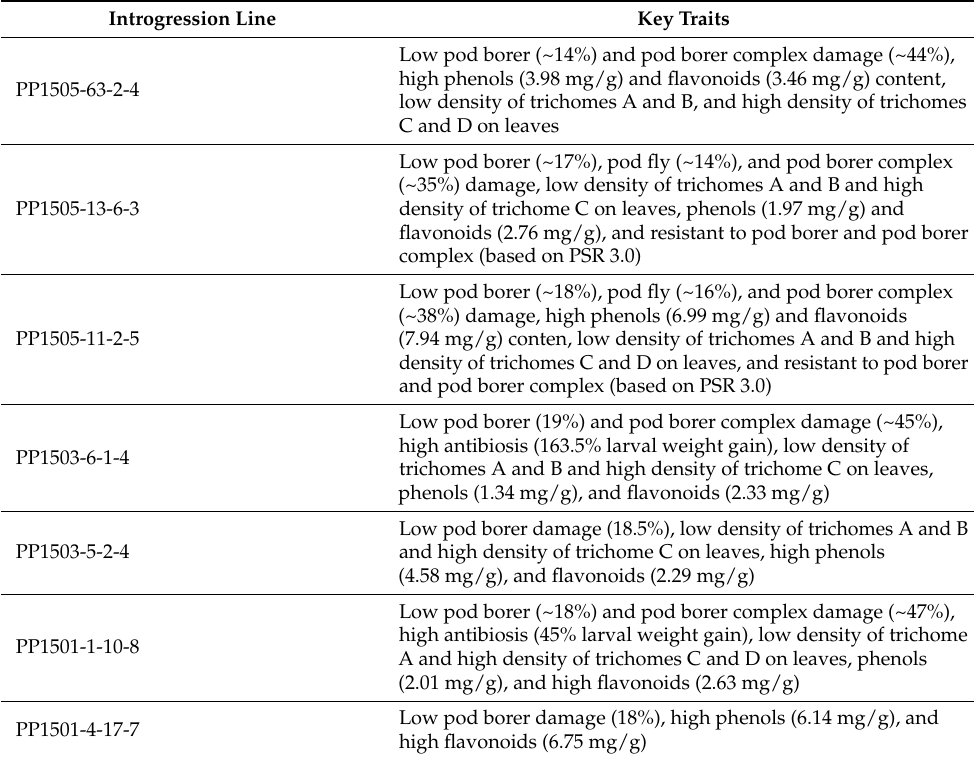
Table 6. Details of the most promising pod borer-tolerant introgression lines that could be utilized in pigeonpea improvement